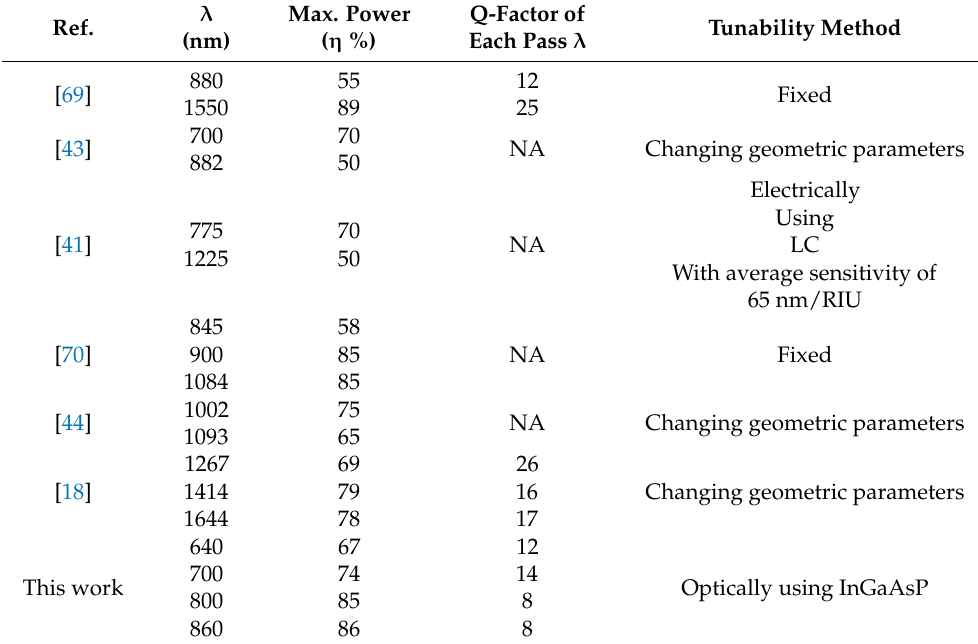
Table 5. Comparison between the proposed tunable multichannel bandpass filter and previous works. λ Max. Power Ref. (nm) Each Pass